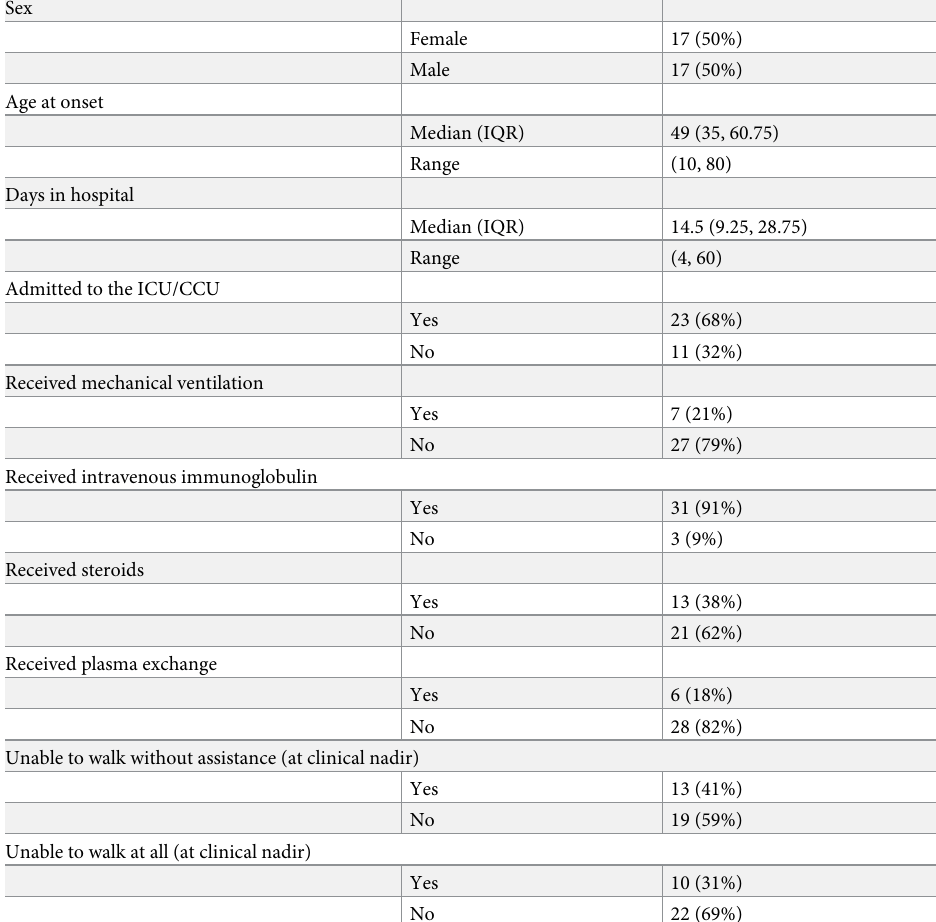
Table 1. Descriptive statistics for 34 GBS patients, Barranquilla,